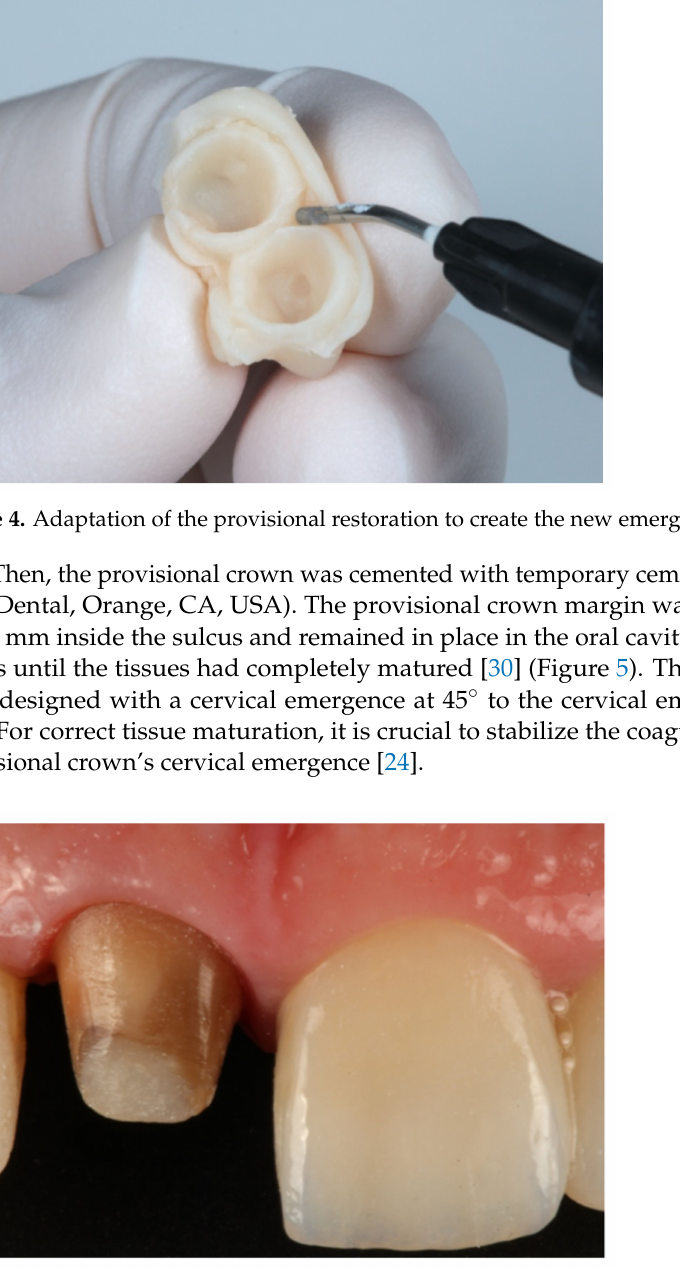
Figure 5. Soft tissue maturation after the provisional BOPT